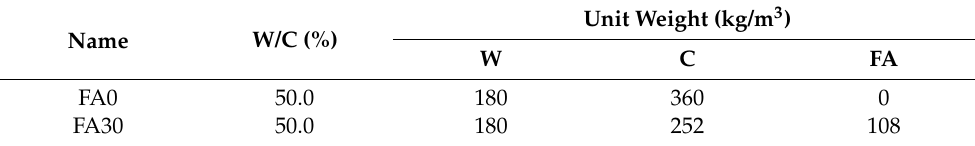
Table 5. Cement paste mix